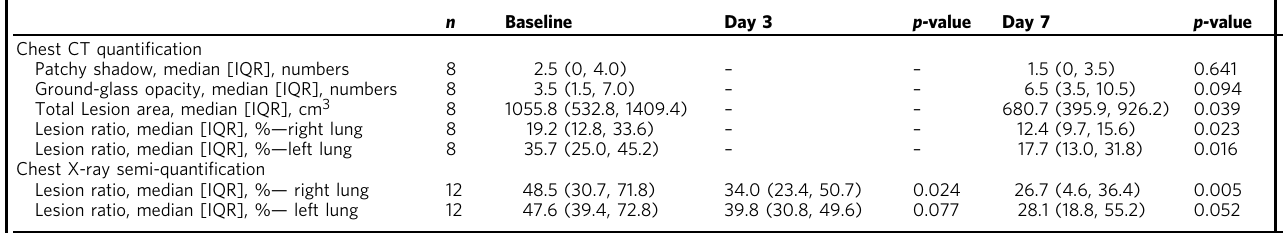
Table 2 Chest radiological imaging quanti fi cation.